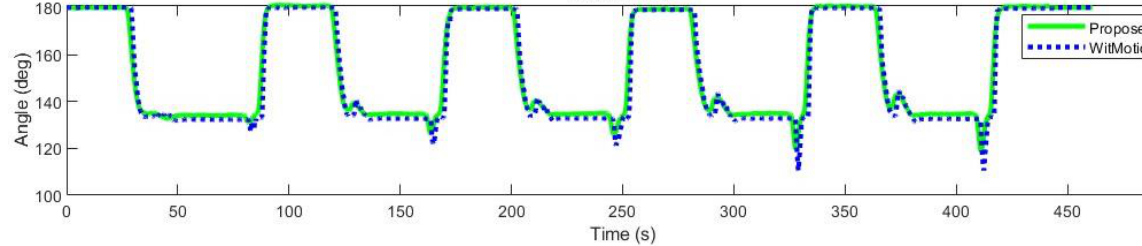
Figure 7. Measured angle using proposed algorithm (PA) and WitMotion (WM) (second trial).